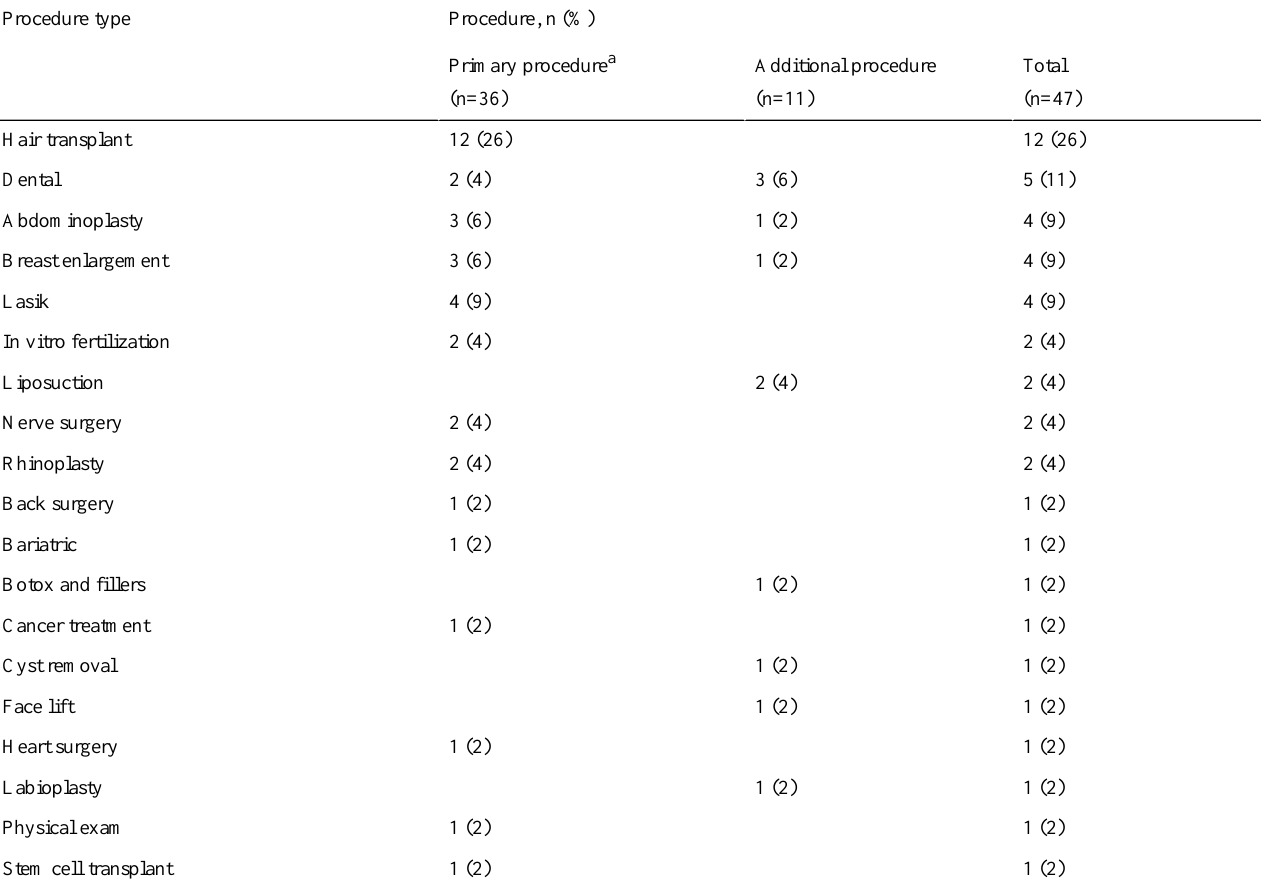
Table 2. Health travelers’primary and additional procedures performed in